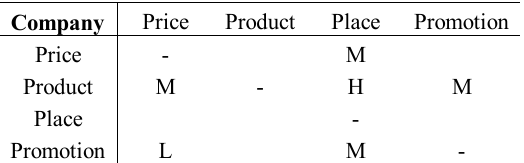
Table5. Pairwise comparisons of alternatives with respect to Market.